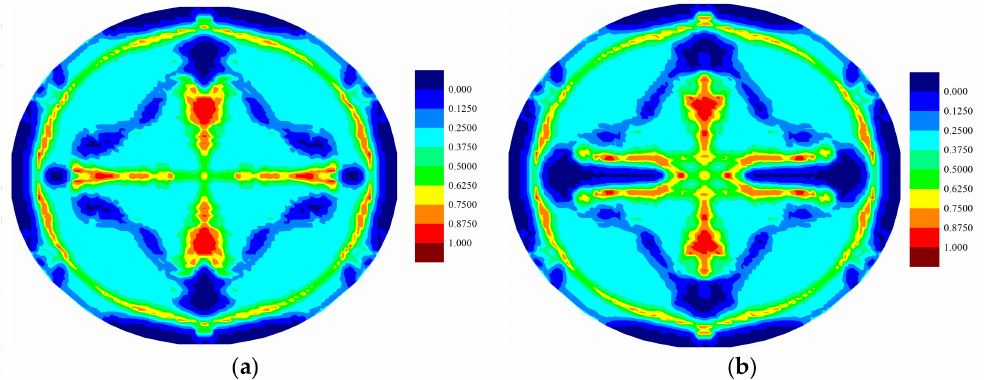
Figure 16. Matrix damage comparison of middle (7th) ply for ( a ) coupled case and ( b ) uncoupled case at 0.3461 × 10 − 3 s.